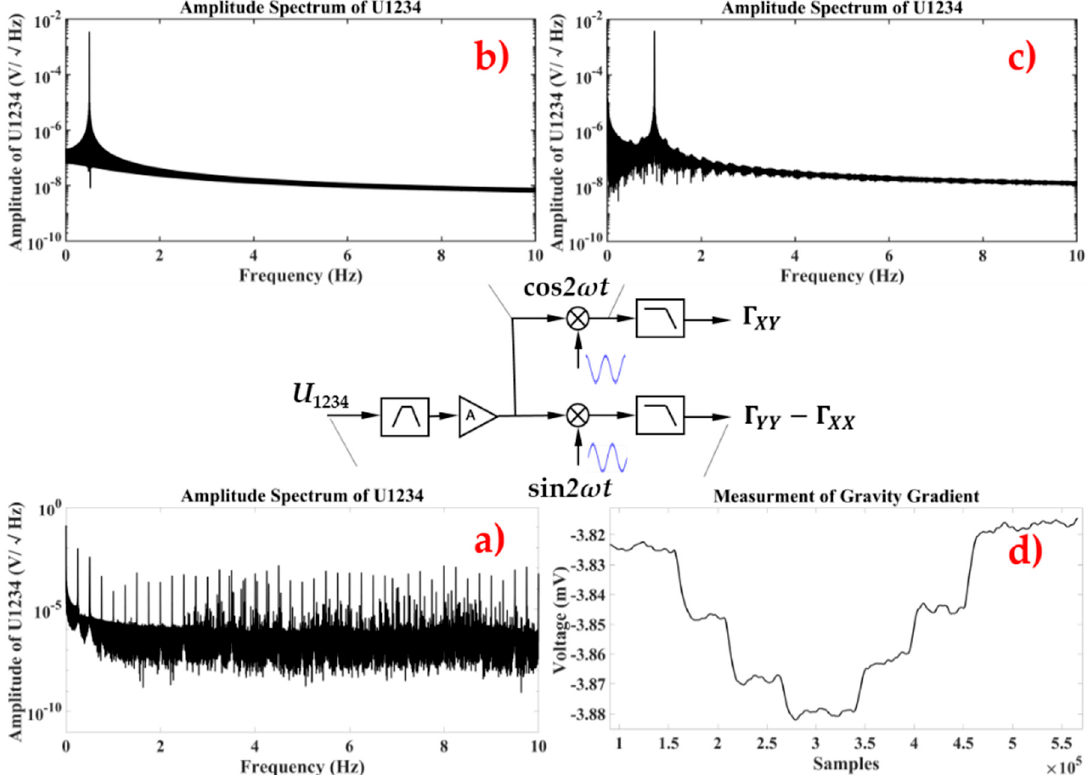
Figure 7. The procedure for gravity gradient data extracting. ( a ) Power Spectrum Density (PSD) of U 1234 . ( b ) PSD of U 1234 after band-pass filter of 0.5 Hz. ( c ) PSD of U 1234 after demodulating. ( d ) Gravity gradient signal was extracted through an averaging of 120